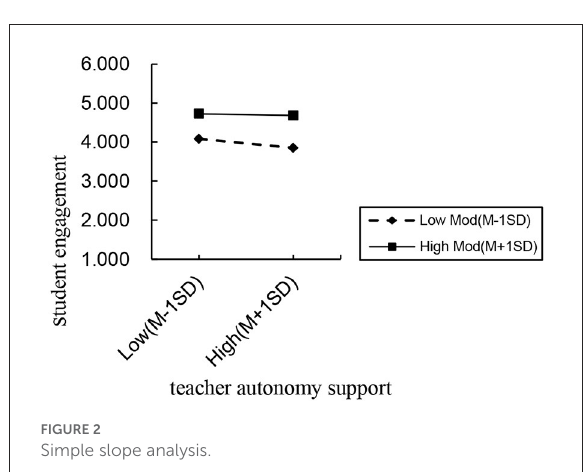
FIGURE2 Simple slope